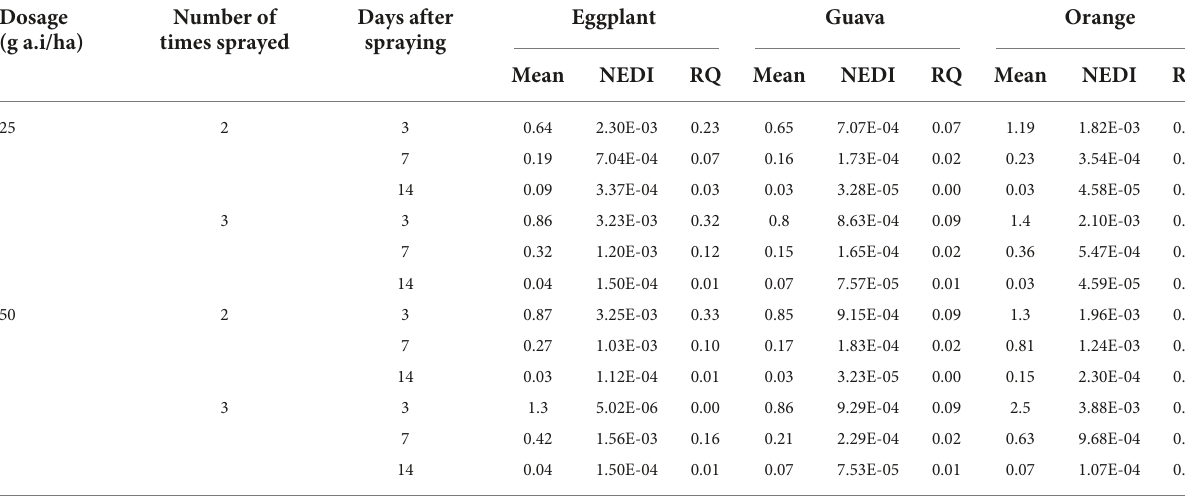
TABLE 6 Long-term exposure calculations of fenpyroximate in eggplant, guava, and orange fruits for the Egyptian consumer using the RQ approach. Dosage (g